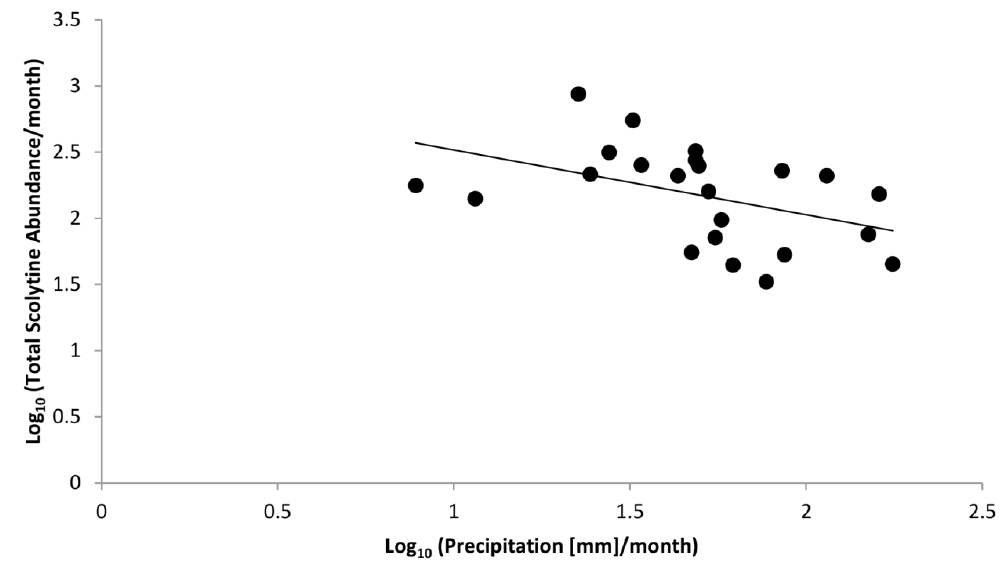
Figure 5. Linear regression of log-transformed data correlating total abundance of scolytines with precipitation.